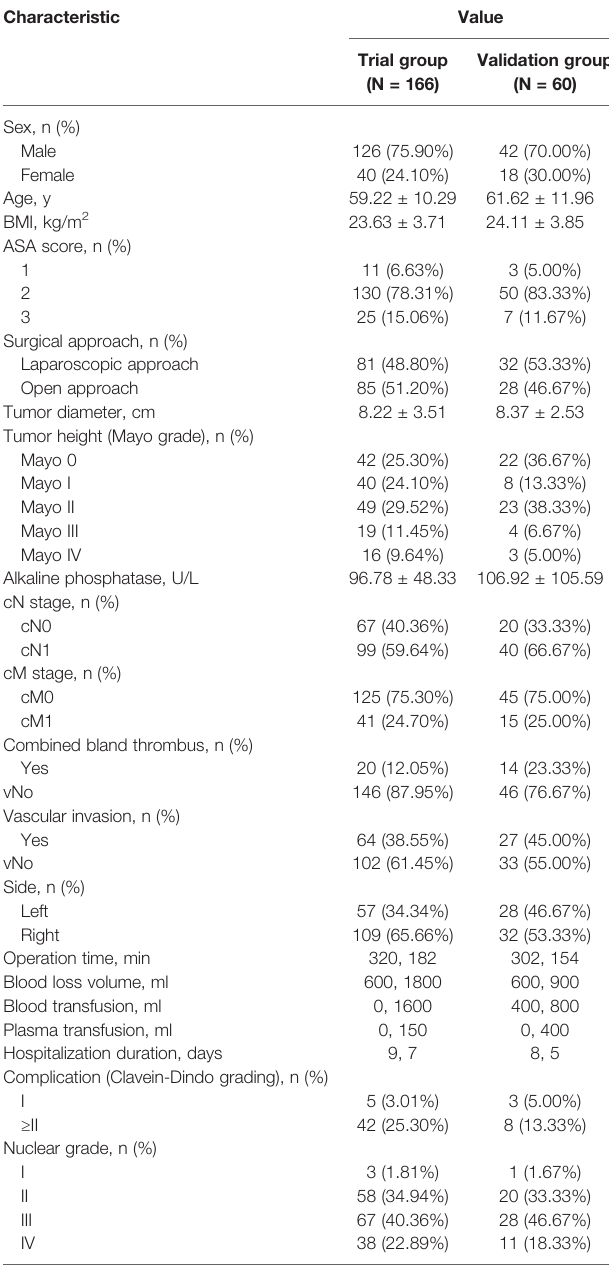
TABLE 2 | Clinical and pathological data of patients in each group. Characteristic